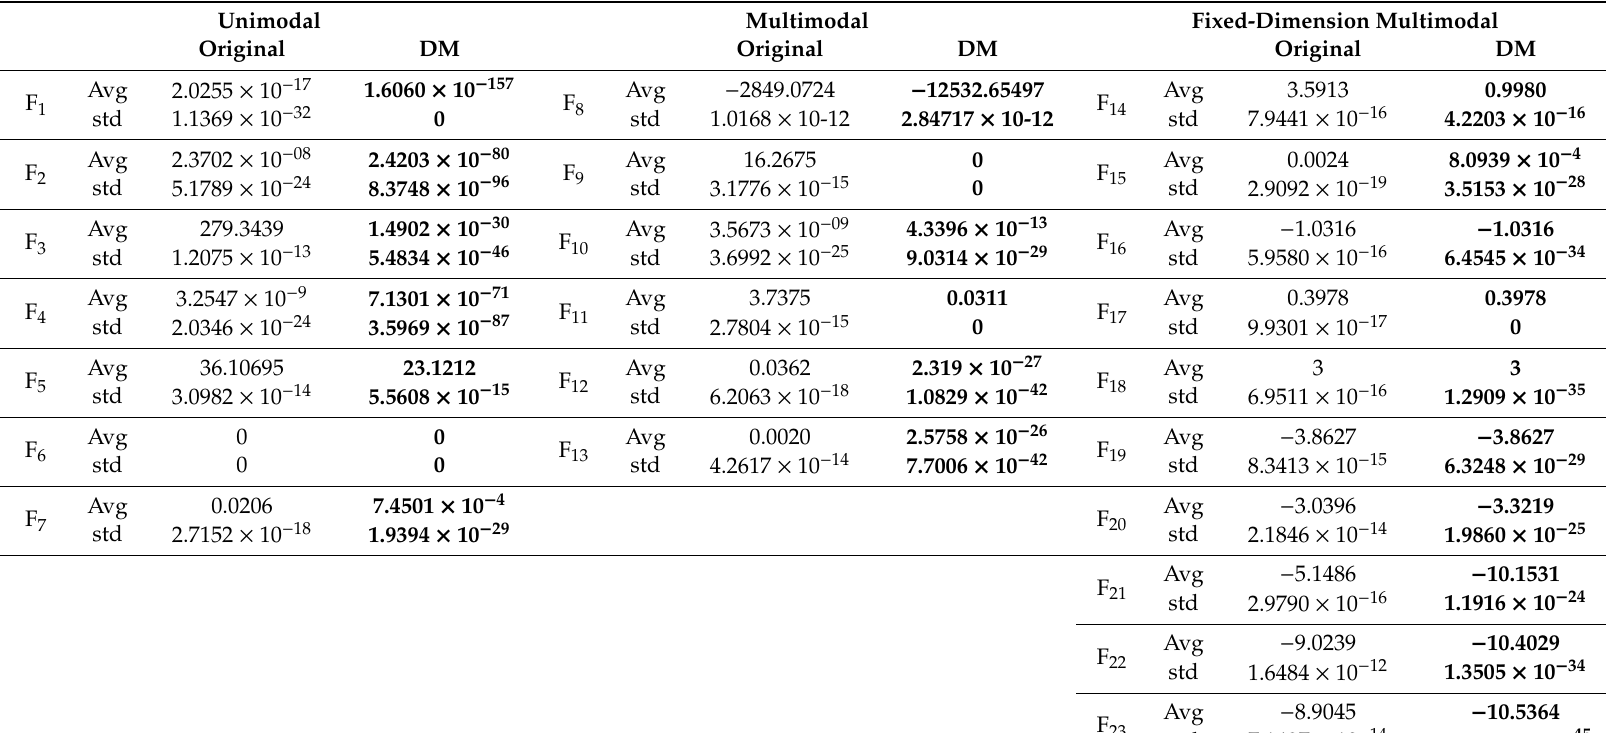
Table 4. Optimization results of gravitational search algorithm (GSA) for original and “modified by DM”